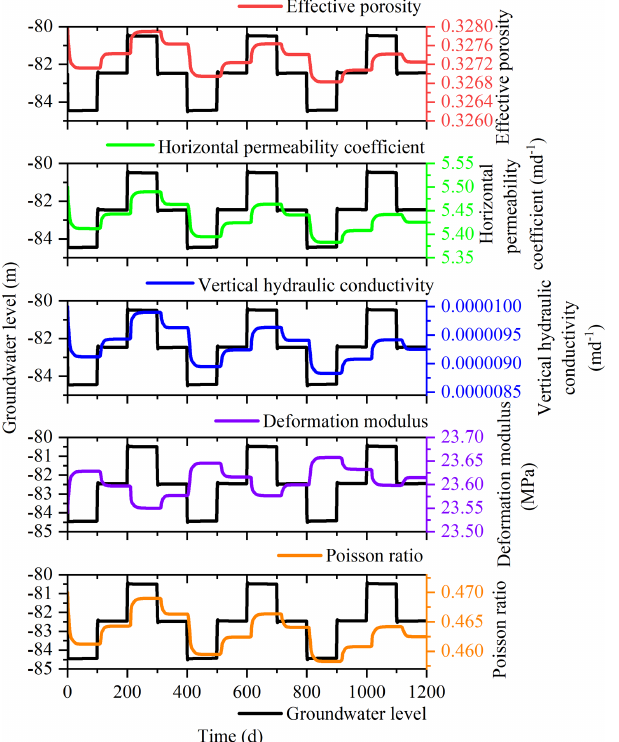
Figure 8. Parameter and water level with stress period in the third confined aquifer group under the second pumping and recharge scheme.